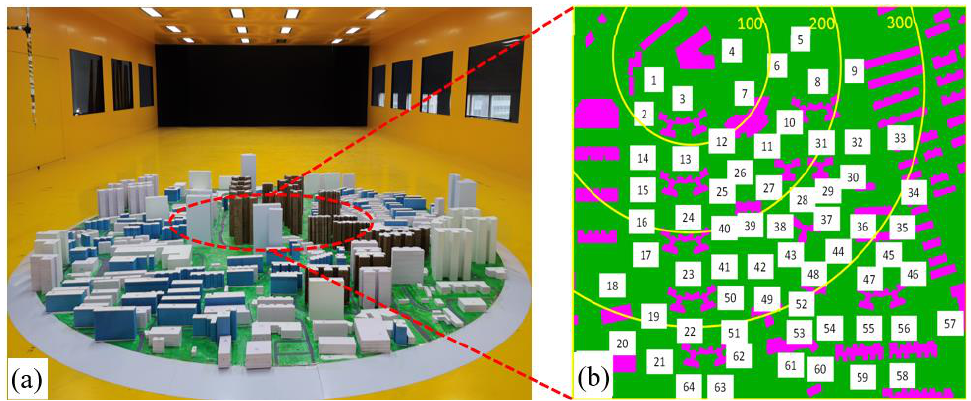
Figure 4. Wind tunnel tests: ( a ) building models in the study area; ( b ) locations of selected monitor- ing points.